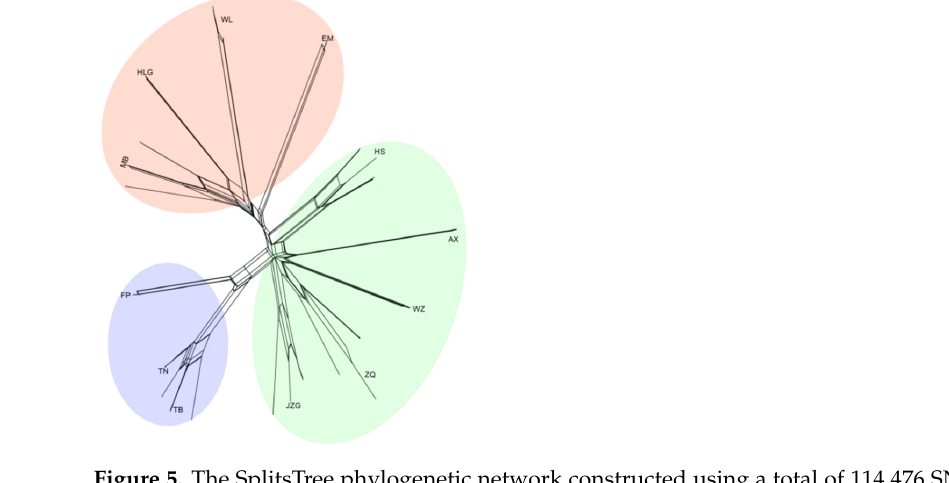
Figure 5. The SplitsTree phylogenetic network constructed using a total of 114,476 SNPs. Parallel edges represent the splits computed from the data. The clusters corresponding to different genetic groups are shown with different colors. The genetic QL group is shown in blue, the MS group is shown in green, and the DQ group is shown in orange.